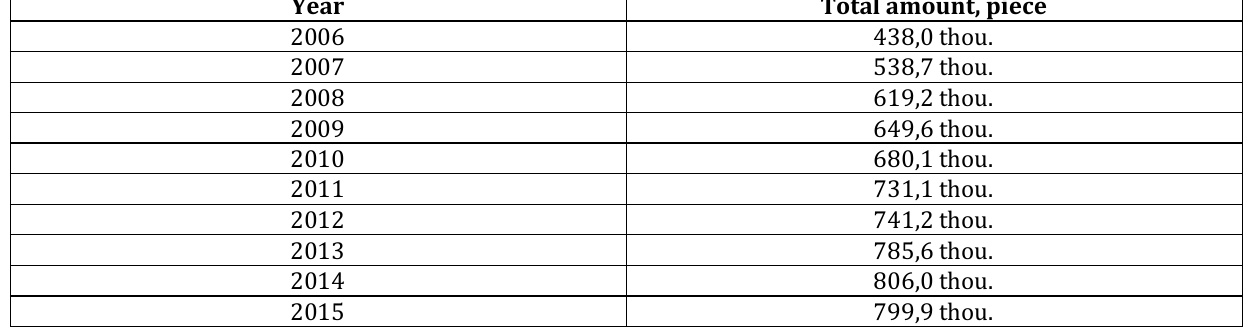
Table 2. Total number of license (annual quota) for a trip to a foreign country for Ukrainian carriers